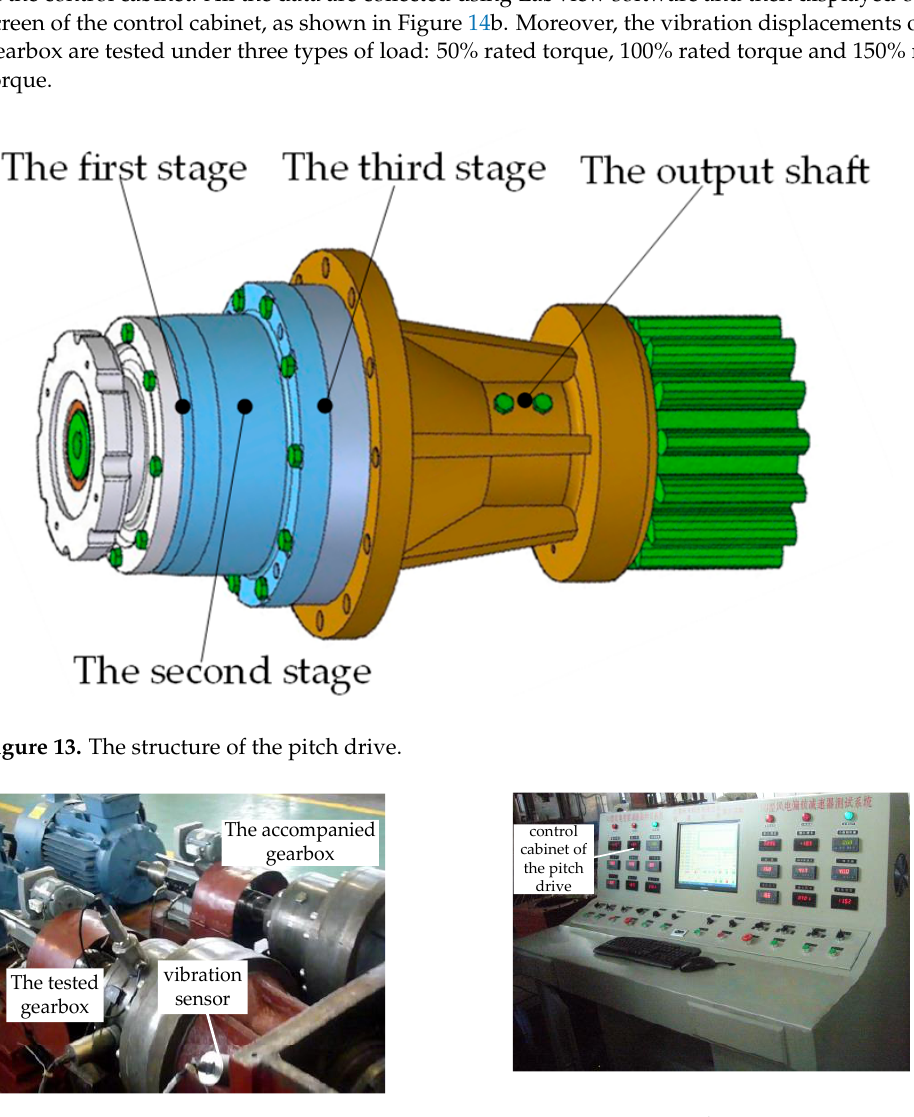
Figure 14. The test rig of the pitch drive. ( a ) Test rig; ( b ) control cabinet.